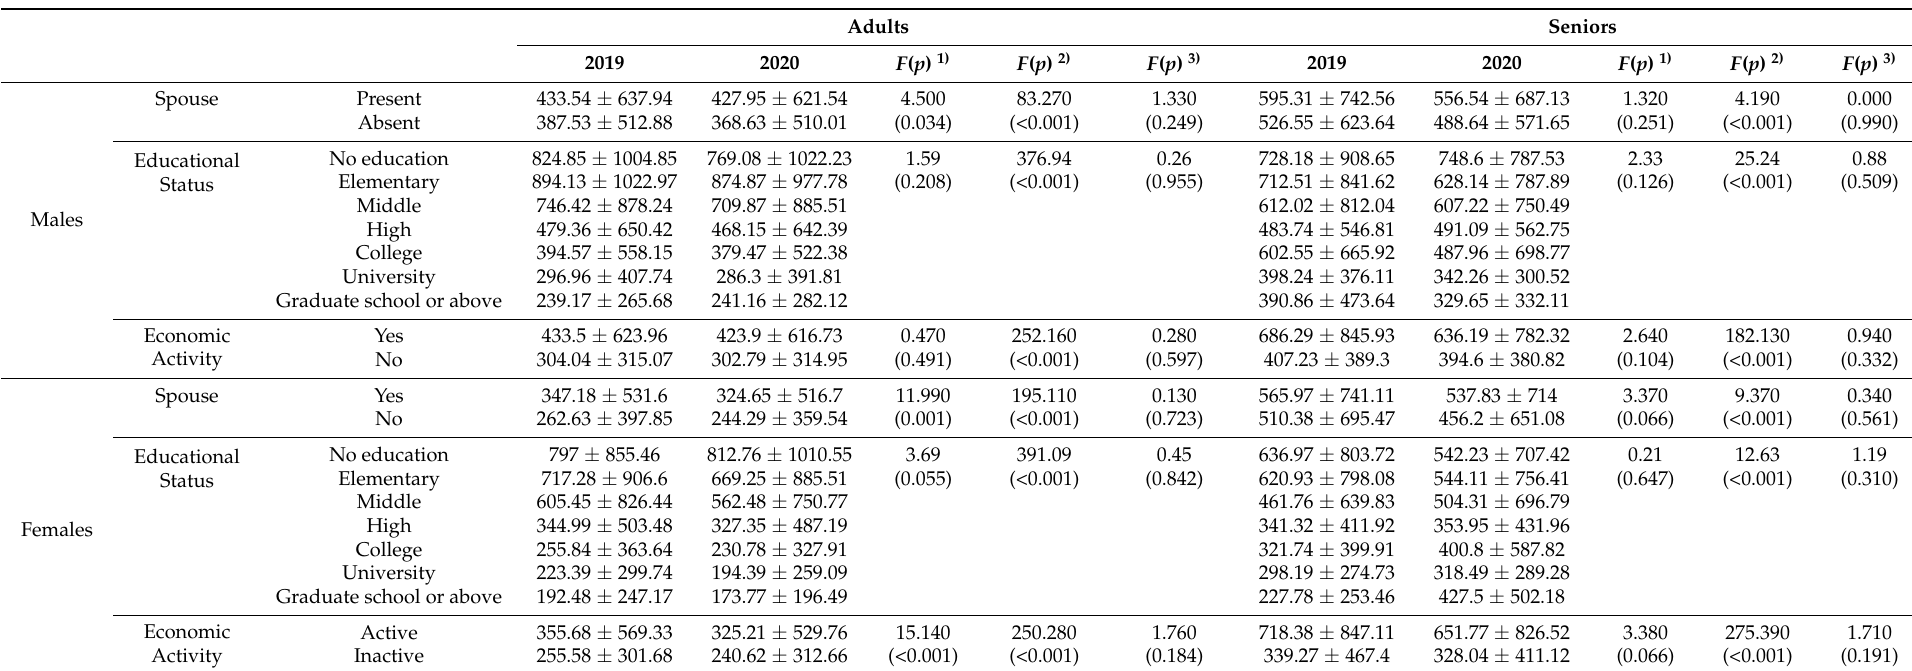
Table 2. Differences in physical activity (high-intensity) by general characteristics of subjects (2019–2020). Adults